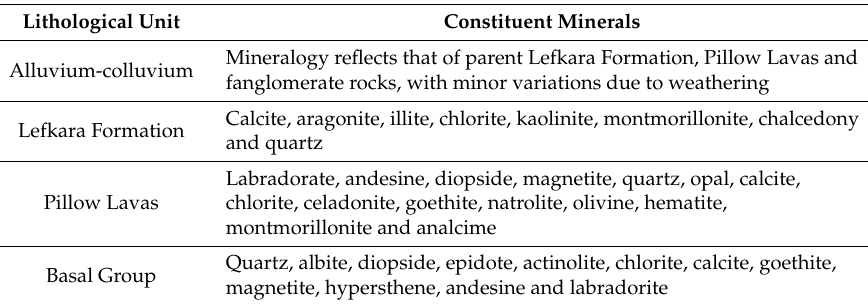
Table 1. Primary and secondary constituent minerals of the lithological units.